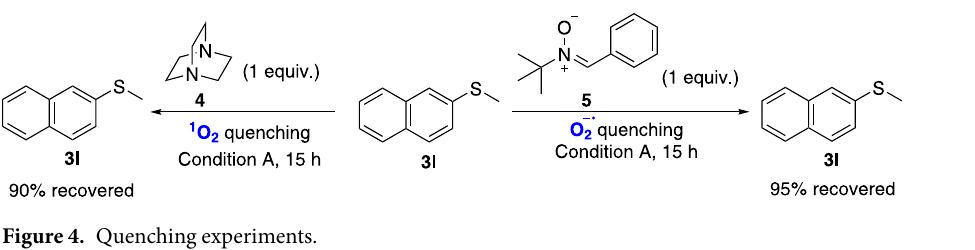
Figure 4. Quenching